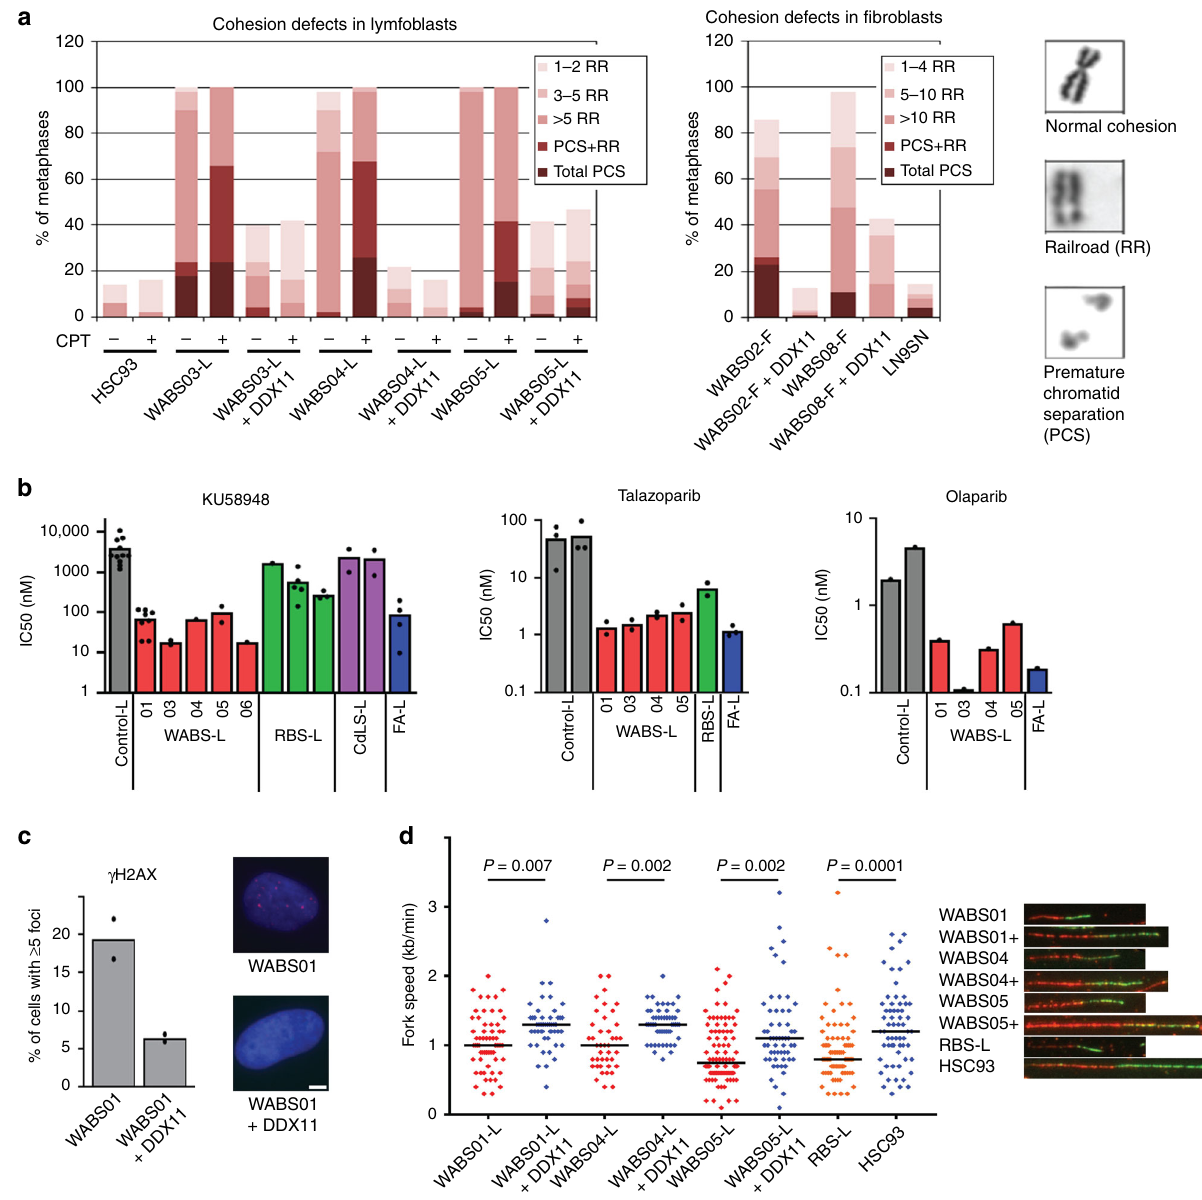
Fig. 2 WABS cells display cohesion loss, PARPi sensitivity, DNA damage and replication stress. a Cohesion defect analysis of WABS cells. Per condition, in total 100 metaphases from two independent experiments were assessed. CPT = 2.5 nM Camptothecin treatment for 48 h. Examples of a normal chromosome, a railroad chromosome (RR) and premature chromatid separation (PCS) are shown. b Lymphoblasts from different patients were continuously exposed to increasing concentrations of PARP inhibitors KU58948, talazoparib and olaparib. After three population doublings of untreated cells, cells were counted and the amounts were determined as percentage of untreated cells. IC50 values from each dose-response curve were